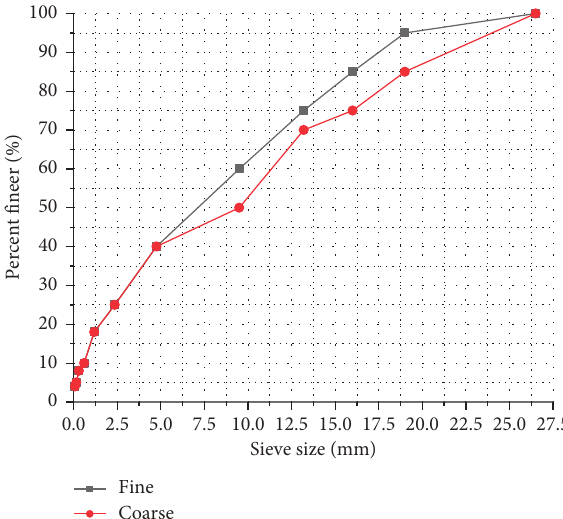
Figure 1: Grading curves of fine and coarse aggregate.